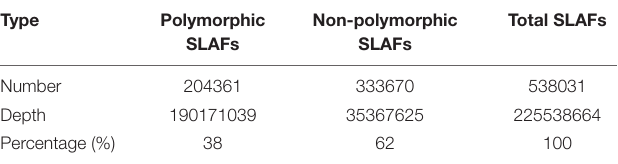
TABLE 2 | Classification of SLAF markers.